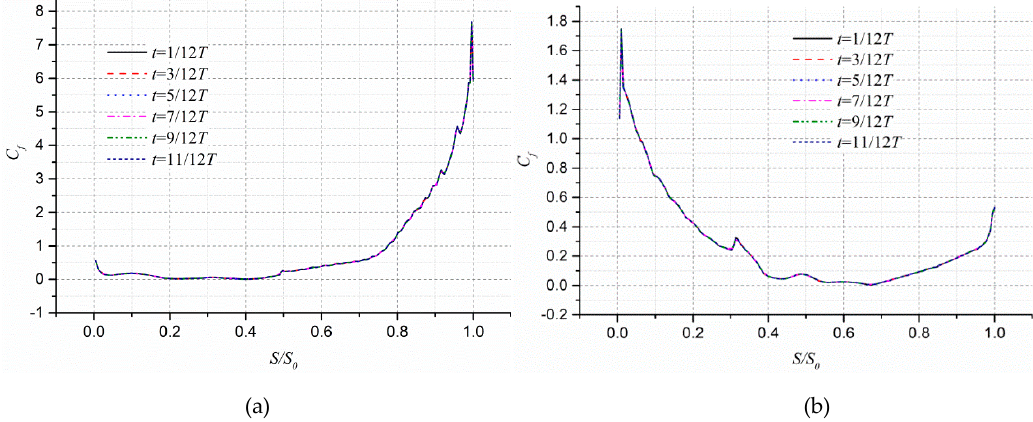
Figure 11. Distribution of the skin friction coefficient on the blade surface for the Z / b 2 = 0.15 cross section: ( a ) pressure surface and ( b ) suction surface.